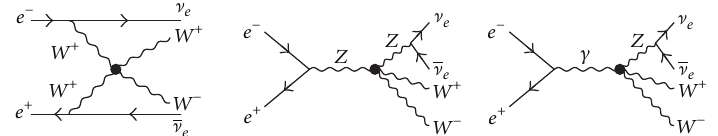
Figure 1: The Feynman diagrams for the 𝑒 + 𝑒 − → ] 𝑒 𝑊 − 𝑊 + ] 𝑒 process in the presence of anomalous quartic 𝑊𝑊𝑊𝑊 , 𝑊𝑊𝑍𝛾 , and 𝑊𝑊𝑍𝑍 couplings.